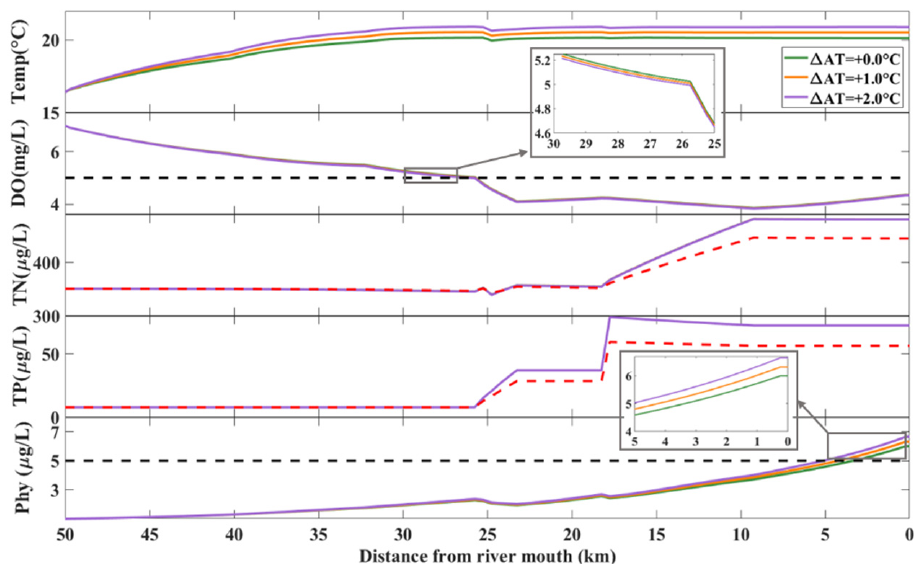
Figure 6. Water temperature/DO/TN/TP/phytoplankton concentration along the Shoalhaven River with the incremental increases Δ AT in air temperature from 0 °C to 2 °C with a decrease of 35% in the streamflow. The black dashed line in the DO concentration is the minimum acceptable level of 5 mg/L, and the black dashed line in the phytoplankton concentration is at 5 µg/L, which is the phytoplankton concentration threshold for an algal bloom. The red dashed lines in the TN and TP concentrations show the levels for no change in temperature or streamflow (from Figure